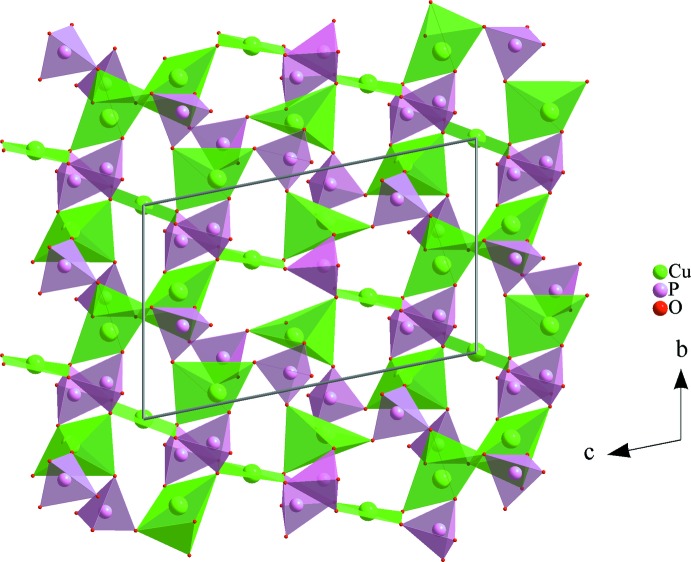
A [Cu3O12] trimer linked to PO4 through corners to form a layer parallel to the (100) plan.